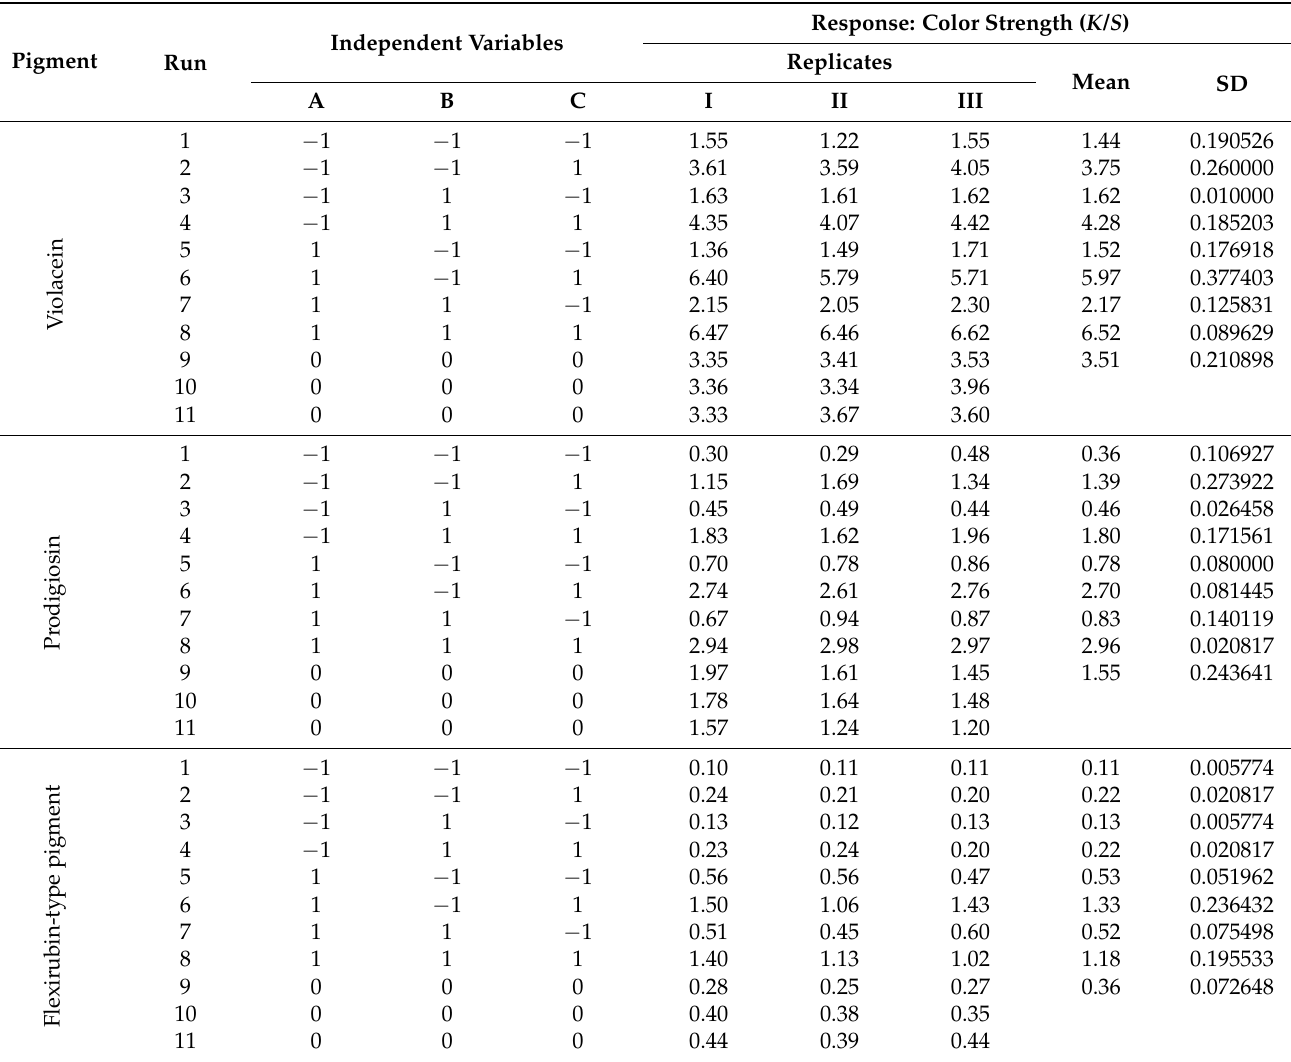
Table 2. Composition of the runs of the two-level full factorial design for each pigment and experi- mental responses ( K / S